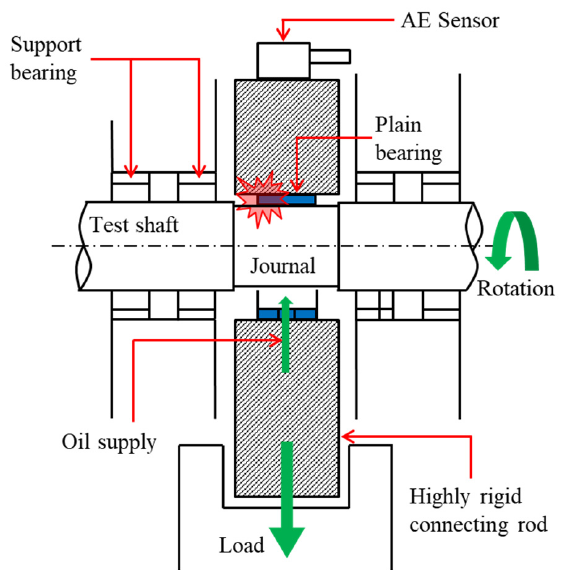
Figure 2. Detailed view of test section.